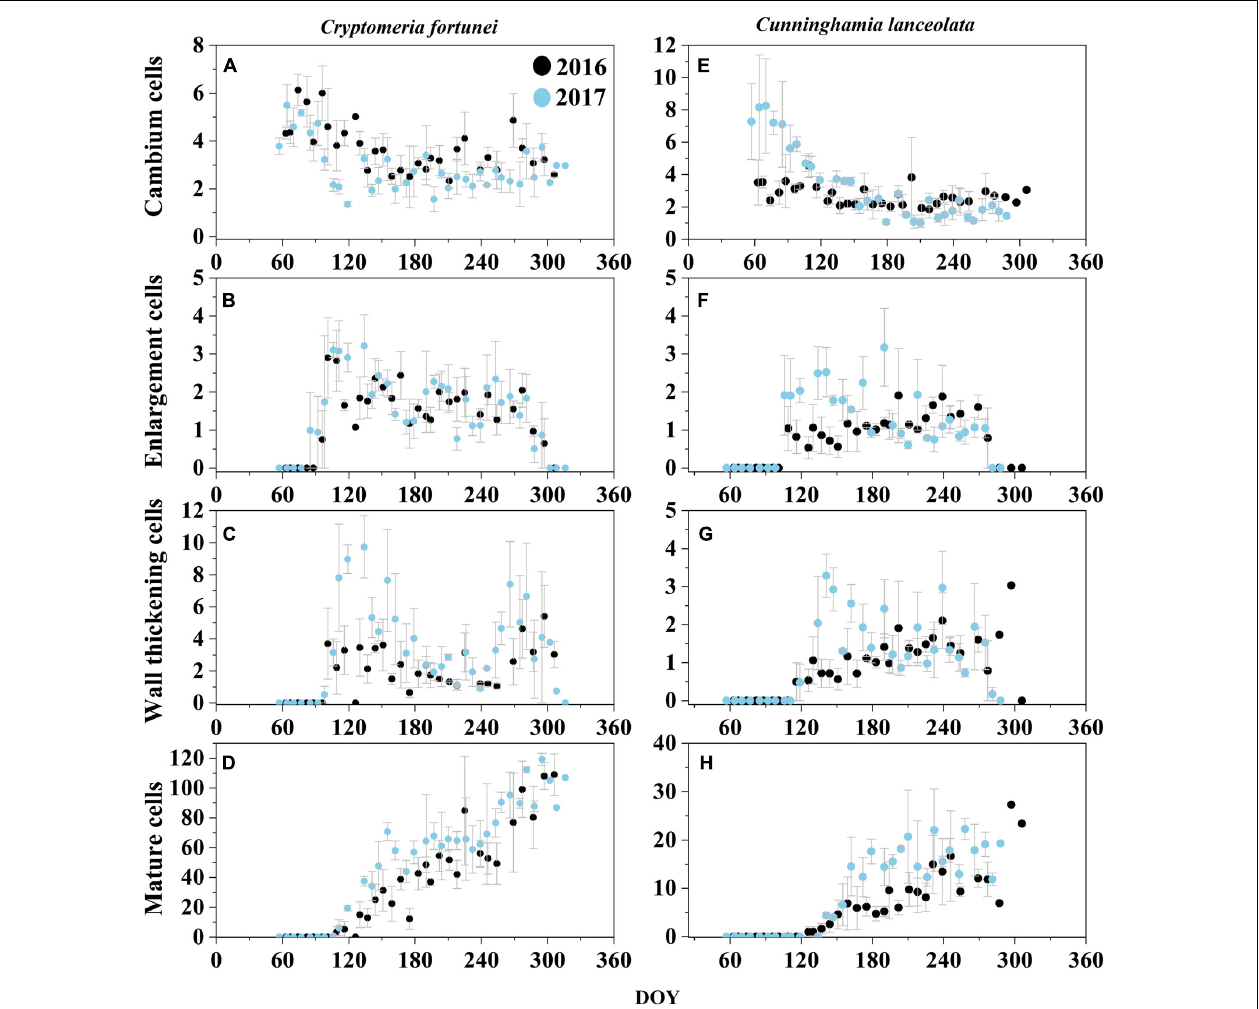
FIGURE 3 | Number of cambial, enlarging, wall thickening, and mature cells of Cryptomeria fortunei (A–D) and Cunninghamia lanceolata (E,F) as observed during 2016 and 2017 at the Gushan Mountain. The dots and the bars represent mean cell number and standard errors among the three selected trees, respectively.